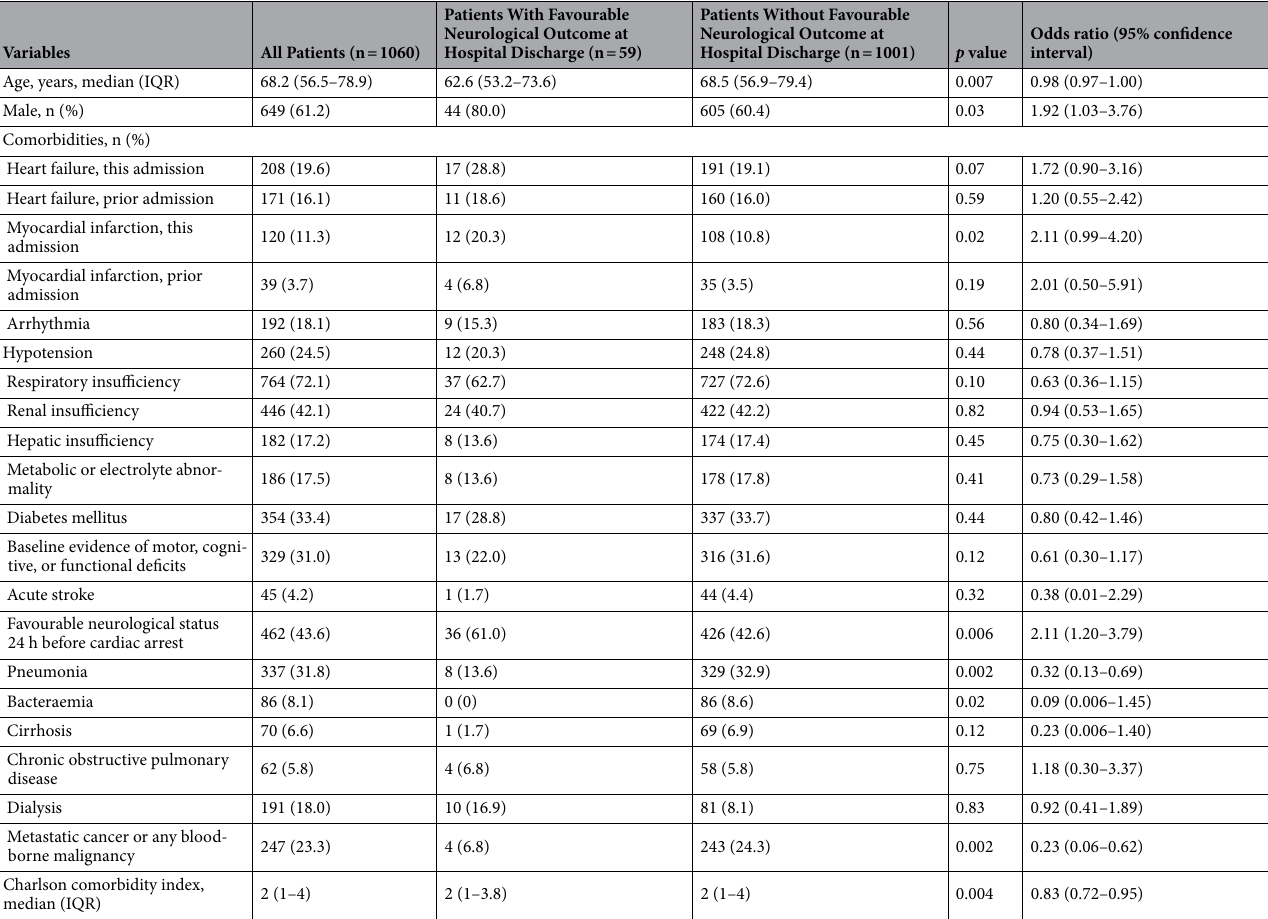
Table 1. Baseline Characteristics of Study Patients. Abbreviations: IQR, interquartile